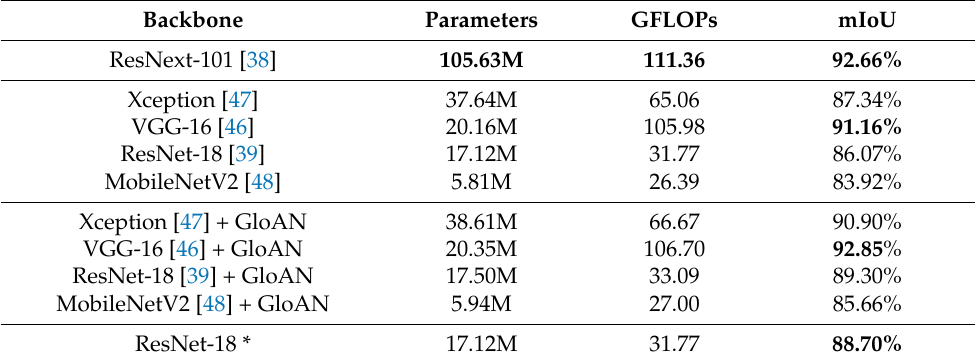
Table 2. Rice lodging segmentation based on DeepLabV3+. Backbone Parameters